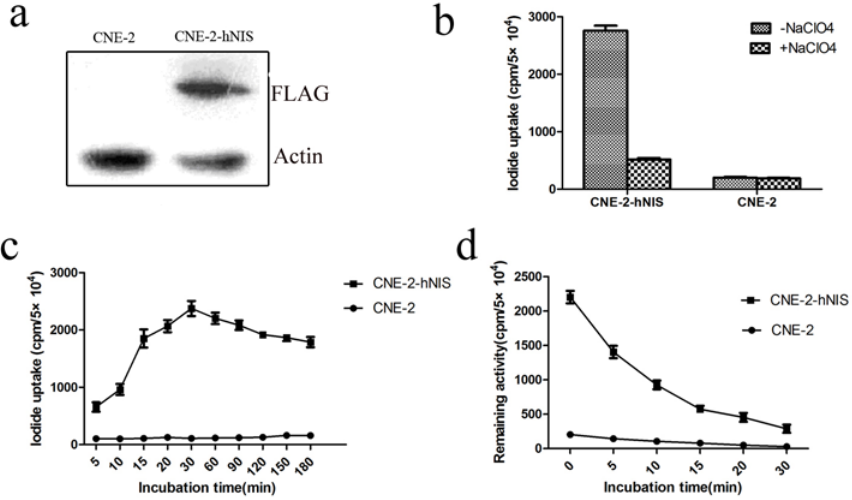
Figure 1. Iodide accumulation in CNE-2-hNIS cells. (a) Western blot of membrane preparations of NIS- transfected cell lines. Lanes from left to right are: CNE-2 and CNE-2-hNIS. (b) Uptake of 125 I was significantly higher in CNE-2-hNIS cells than in CNE-2 cells ( t = 50.5, P < 0.05). Uptake inhibition by perchlorate was highly significant ( t = 42.3, P < 0.05). (c) Internalization of iodide into CNE-2-hNIS and CNE-2 cells. (d) Iodide efflux from CNE-2-hNIS and CNE-2 cells after 1 h incubation with Na 125 I. Data are expressed as mean ± SD (n = 3).